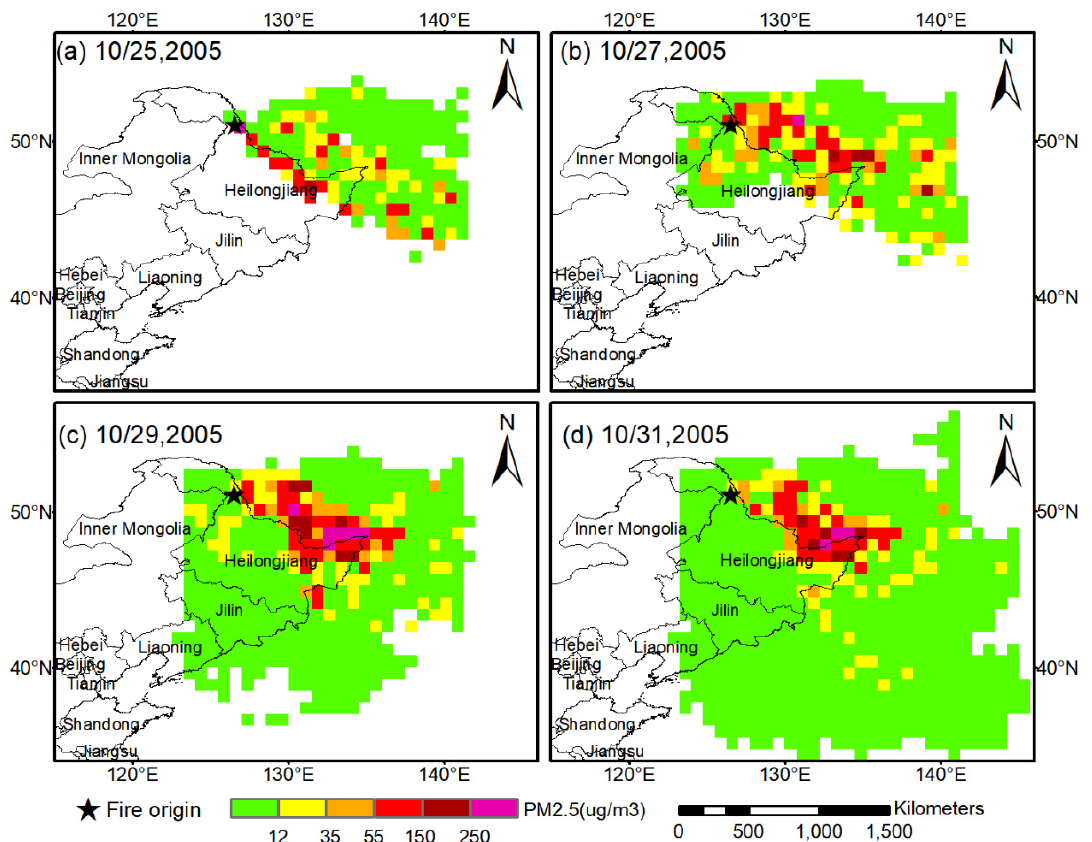
Figure A1. Simulated smoke plume from the Huma fire. Each square box is a model grid point (approximately 25 km × 25 km). The names in black are provinces. The green, yellow, orange, red, brown, and purple colors represent good, moderate, unhealthy for sensitive groups, unhealthy, very unhealthy, and hazardous air quality levels, respectively. Panels ( a – d ) are 25, 27, 29, and 31 October 2005, respectively.